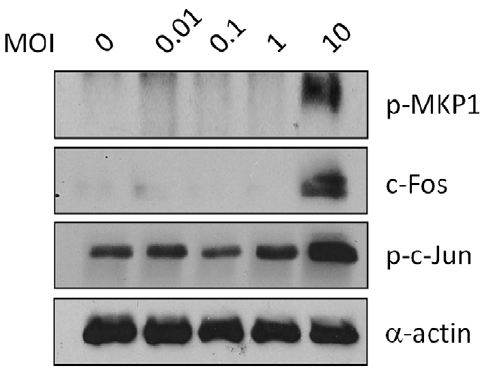
Figure 5. Effect of fungal burdens on MKP1, c-Fos and c-Jun activation. A431 vaginal ECs were infected for 2 h with C. albicans SC5314 at MOI’s ranging between 0.01 and 10. Total protein was isolated and phosphorylation of MKP1 and c-Jun and c-Fos induction was assessed by Western blotting. Bands are shown alongside an a - actin loading control. Data are representative of four independent experiments.